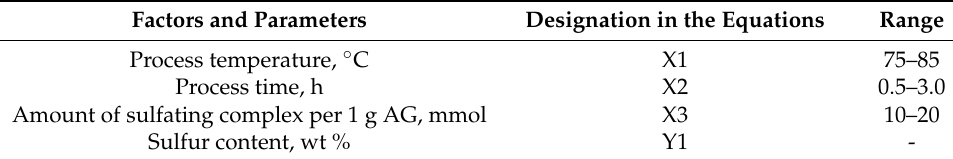
Table 2. Independent factors and output parameter (experimental results).